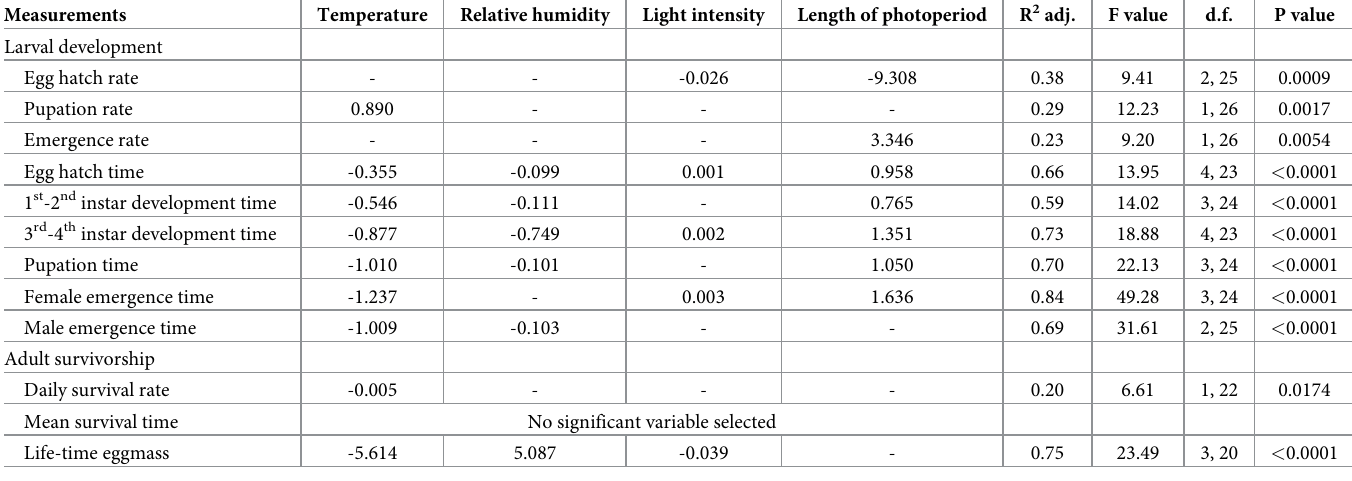
Table 3. Correlations between larval development, adult survivorship and environmental variables. Variables were selected by stepwise regression analysis at signifi- cant level of 0.05. Full results were shown in S3